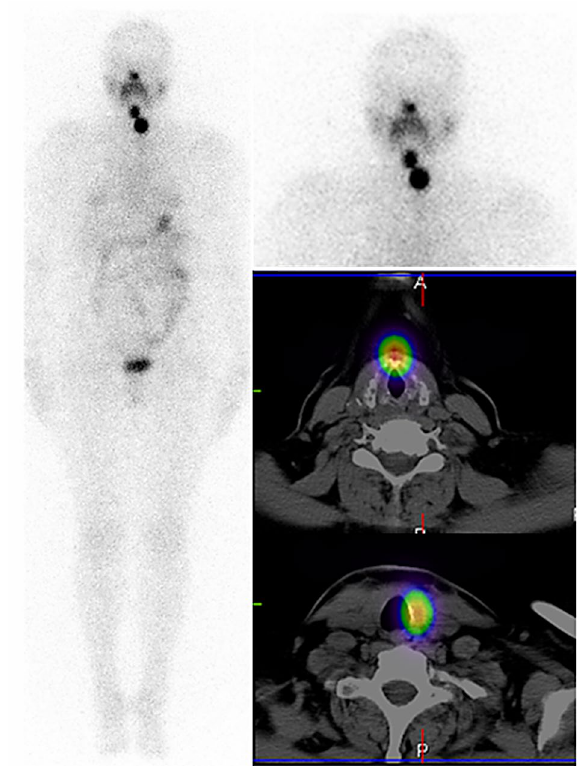
Figure 1. 131 I-WBS and SPECT/CT of the neck obtained 3 days after administration of 3.7 GBq (100 mCi) 131 I in order to ablate thyroid remnants in a patient who 2 months previously had undergone complete thyroidectomy because of DTC (pT3N0M0 with vascular invasion). The images show two iodine-avid areas in the postoperative bed: one located midsagitally, at the level of the hyoid bone, most likely corresponding to the pyramidal lobe; the other one—in the left thyroid lobe